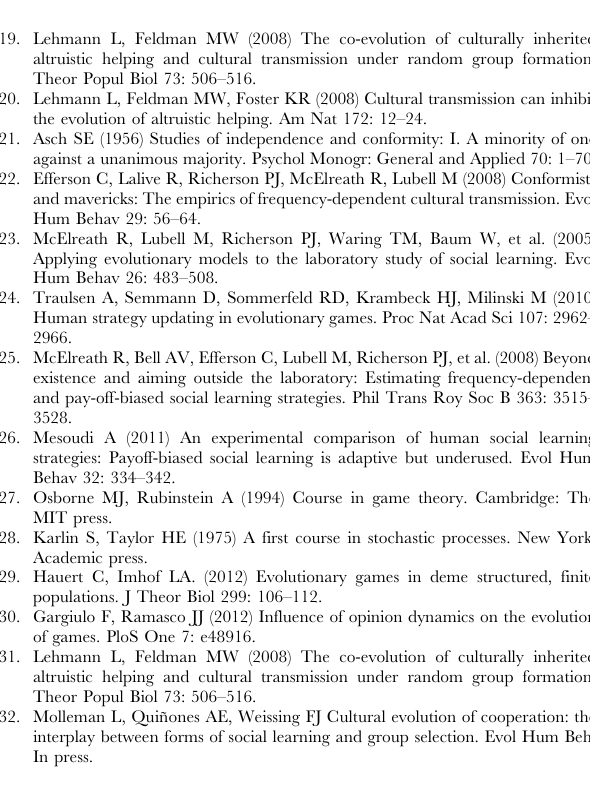
Figure S1 Illustration of the logistic function for three values of b .